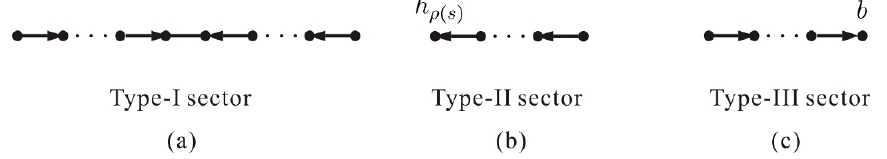
Figure 9 . Graphs (a) and (b) correspond to chains led by a 2 H n f h re(cid:12)ned graphic rule. A contraction of the form ( : : : (cid:1) F (in (a)) provides a type-1 line, while a contraction of the form ( : : : (cid:1) F (b)), k h (cid:1) F (in (b)), F (cid:1) k b (in (a) and (b)) or k h (+) ( (cid:0) ) (cid:26) ( s )